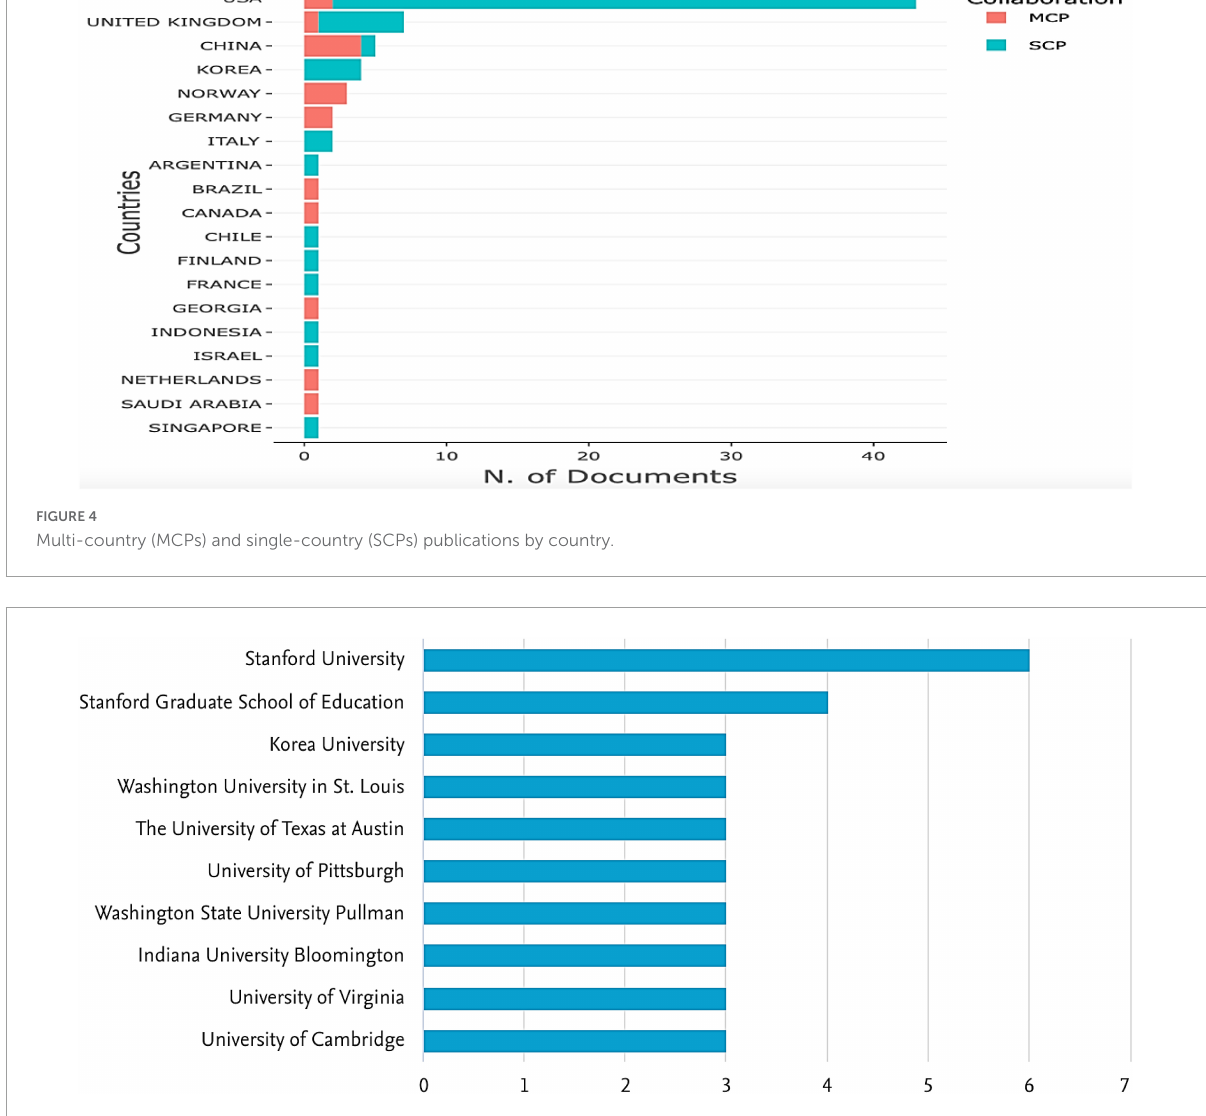
FIGURE5 Top 10 most prolific